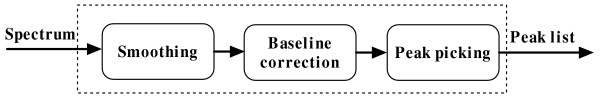
Peak detection framework. The input mass spectrum is transformed into a list of peaks.